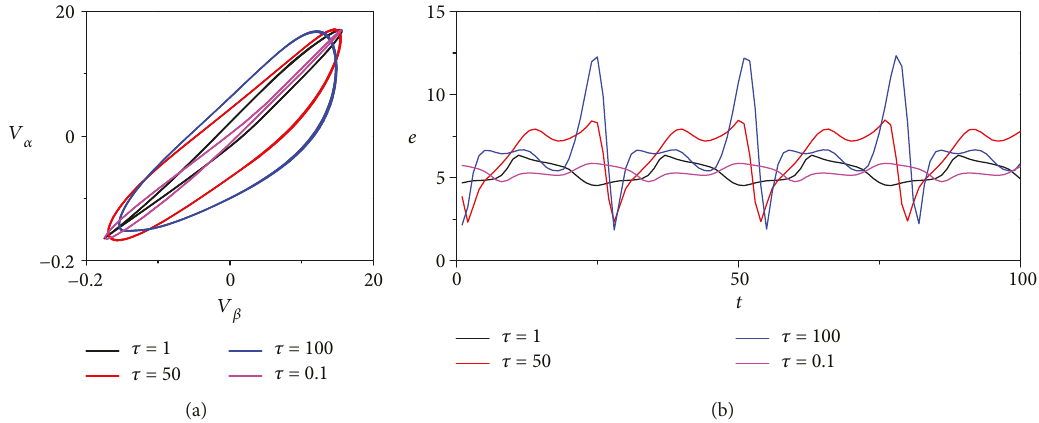
Figure 11: Phase portraits and error e when di ff erent time-lag are calculated at H